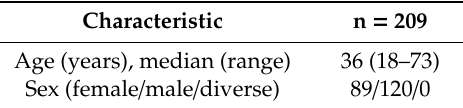
Table 1. Subjects’ characteristics.